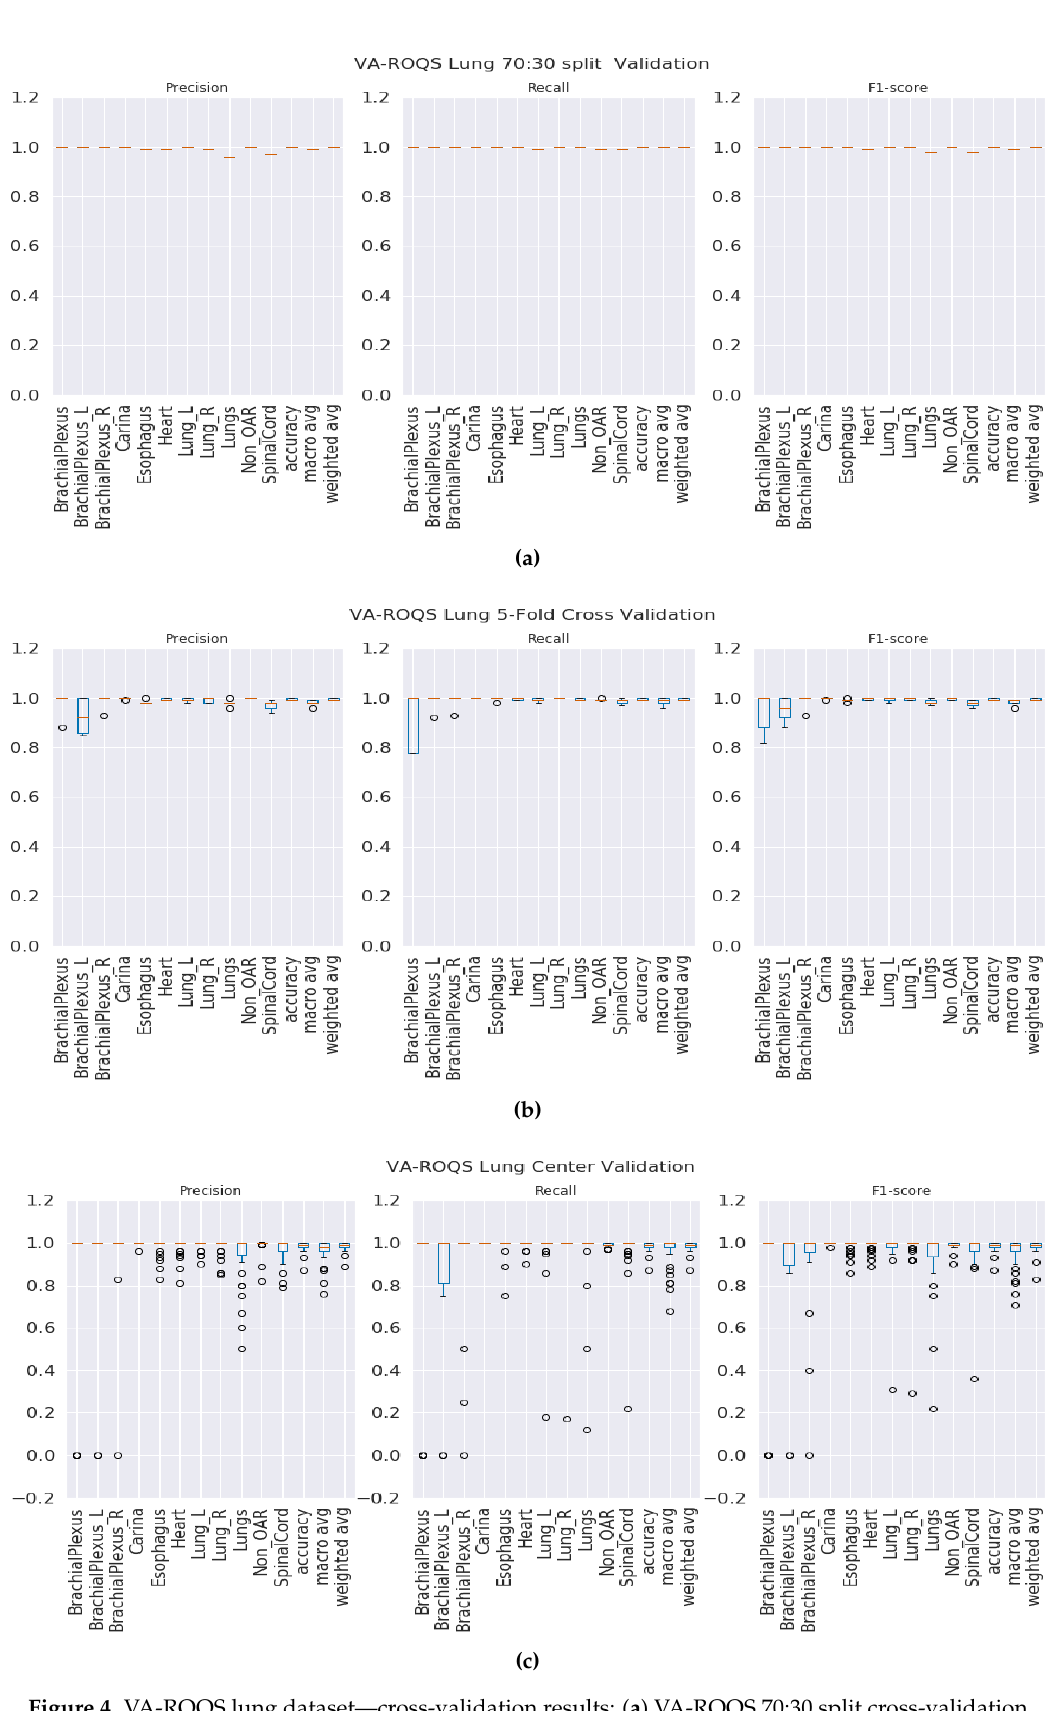
Figure 4. VA-ROQS lung dataset—cross-validation results: ( a ) VA-ROQS 70:30 split cross-validation ( b ) VA-ROQS 5-fold cross-validation ( c ) VA-ROQS center based